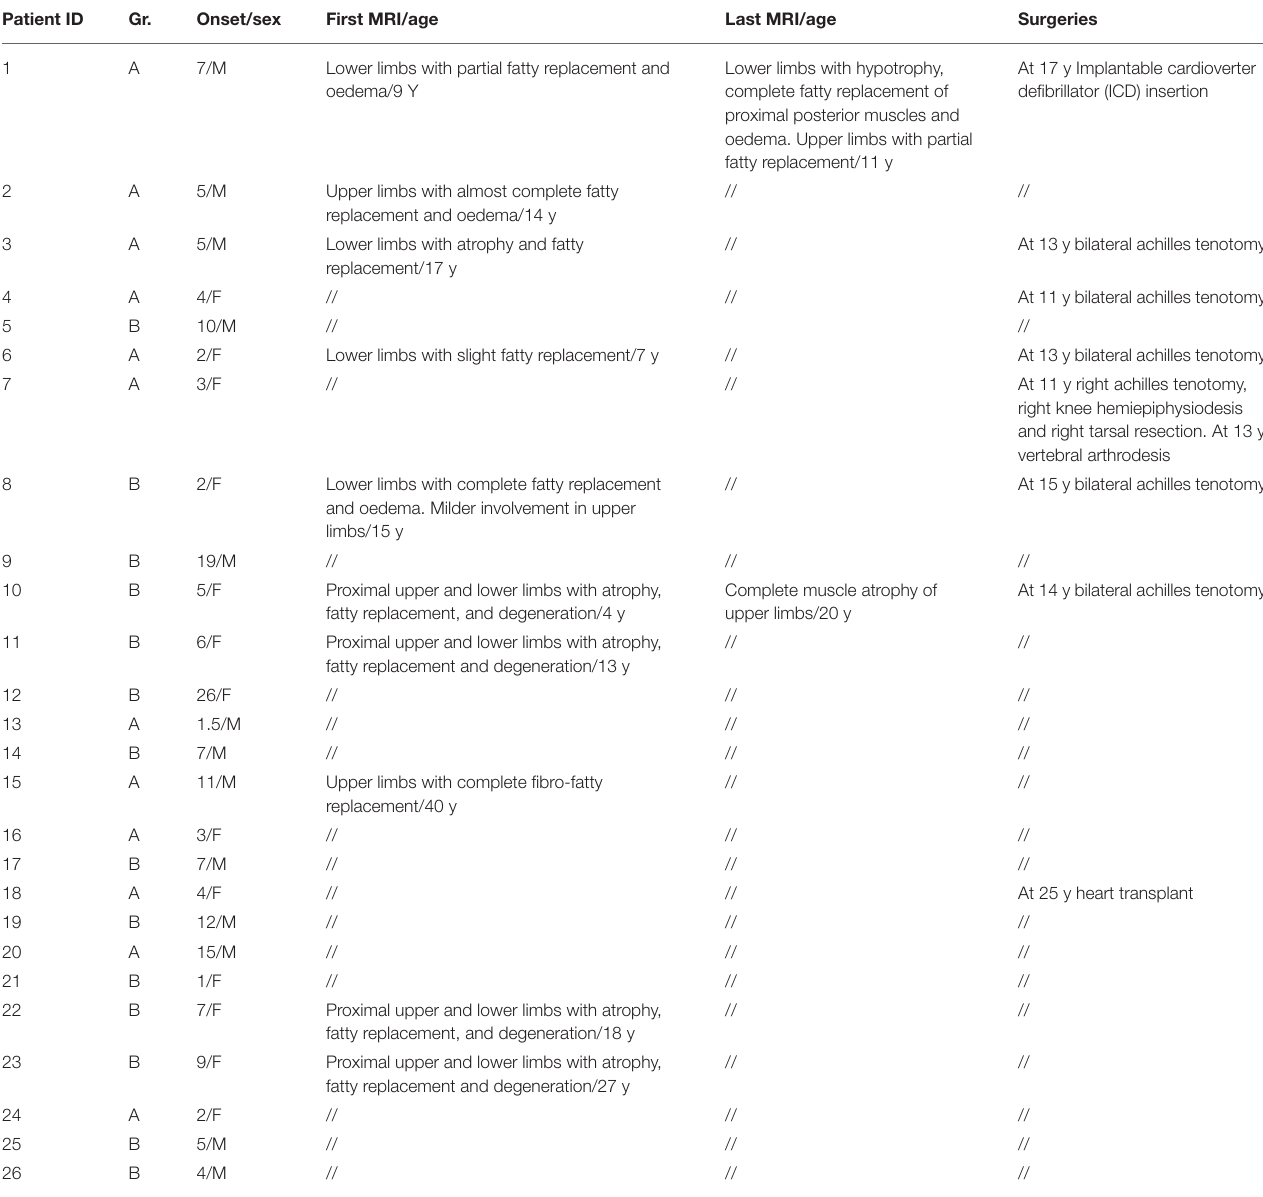
TABLE 5 | MRI and surgical data of the studied cohort. Patient ID Gr. Onset/sex First MRI/age Last MRI/age Surgeries Lower limbs with partial fatty replacement and oedema/9 Y